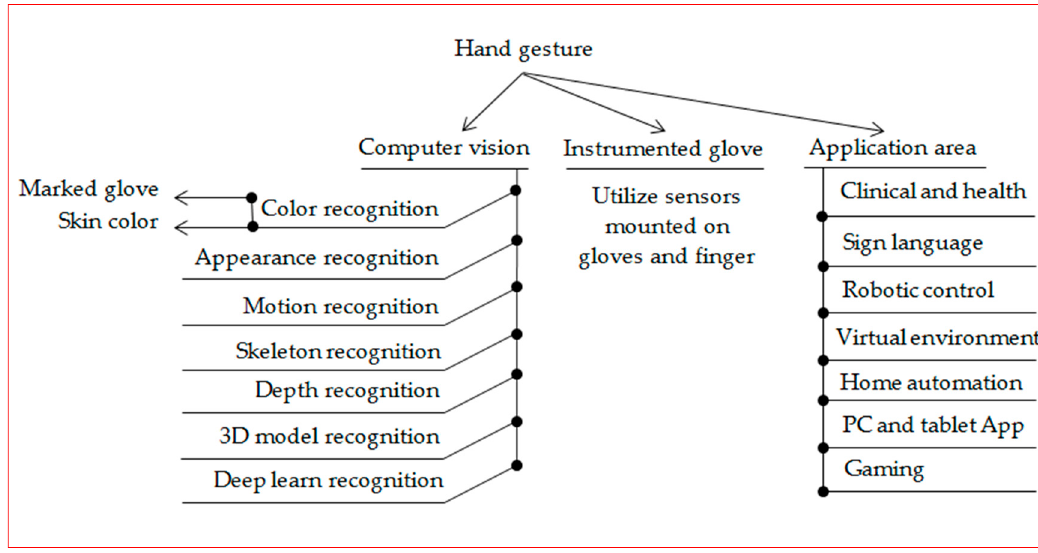
Figure 2. Classifications method conducted by this review.